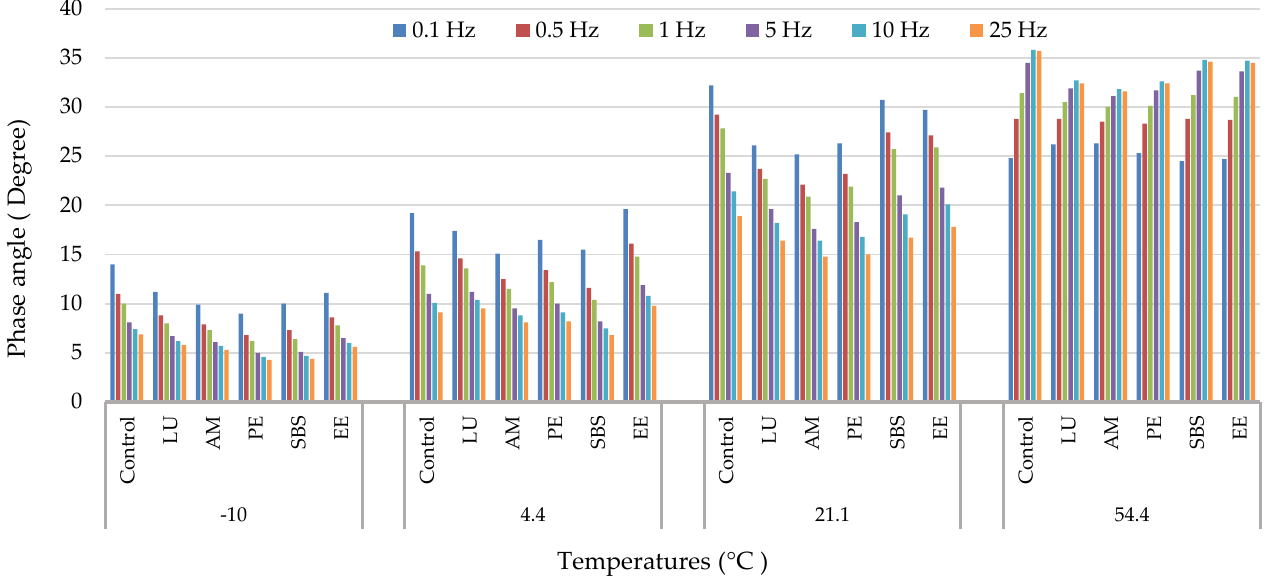
Figure 9. Phase angle versus frequencies at different temperatures.